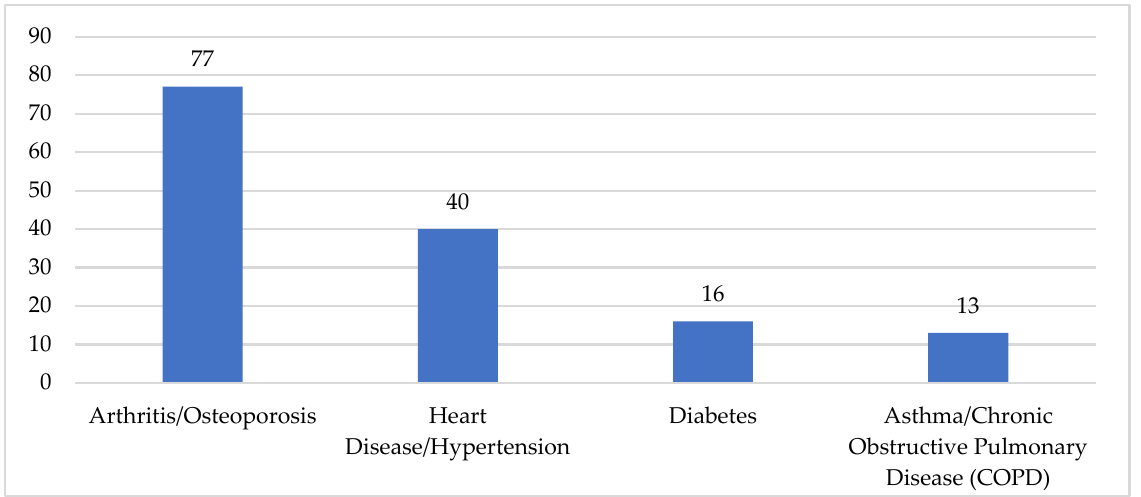
Figure 1. Main diseases ( n ). Some respondents reported more than one category of main disease.